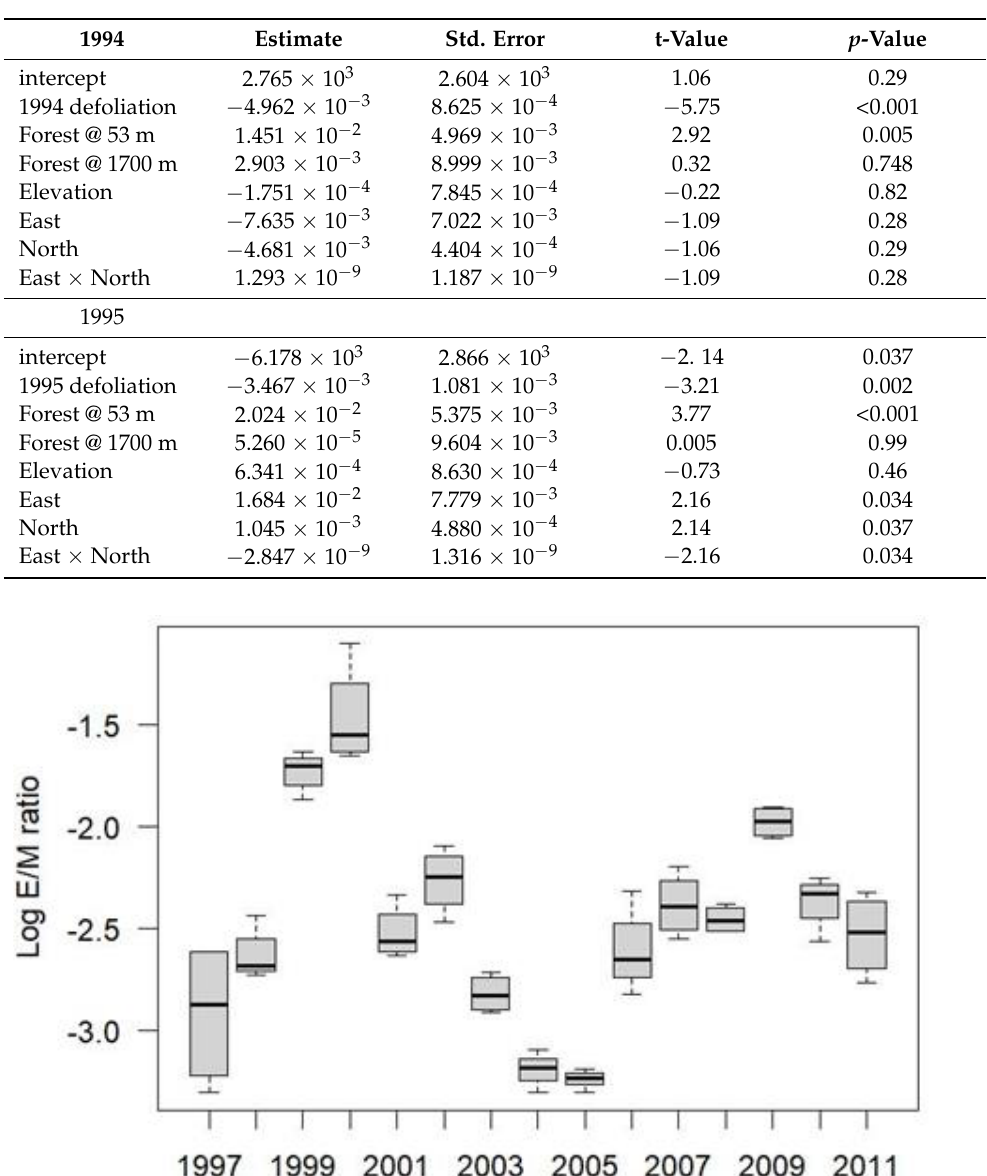
2000, and 2009 were included in the analysis. Table 1. Results from linear regression of forest tent caterpillar E/M ratio onto defoliation, forest cover, and geographic trend variables, for the years 1994 and 1995.